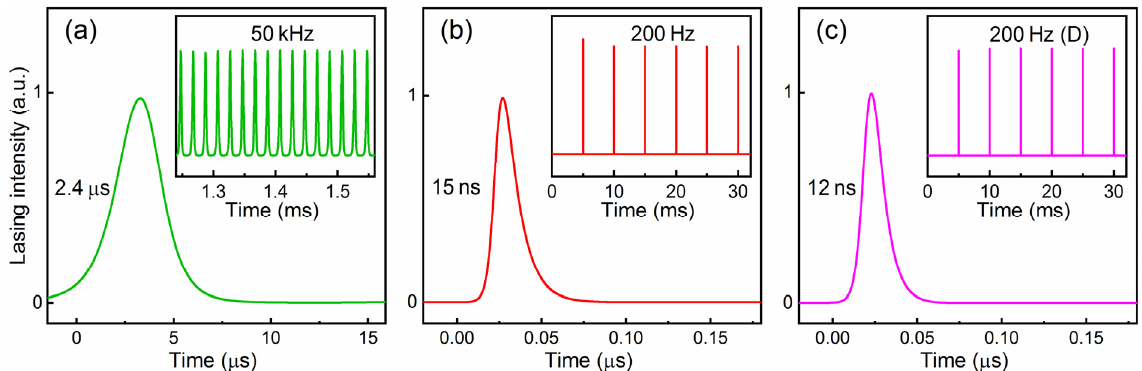
Figure 10. Simulated Q-switched single pulse profiles and temporal pulse sequences (inset). ( a ) Passive Q-switching, ( b ) active Q-switching, and ( c ) double Q-switching.